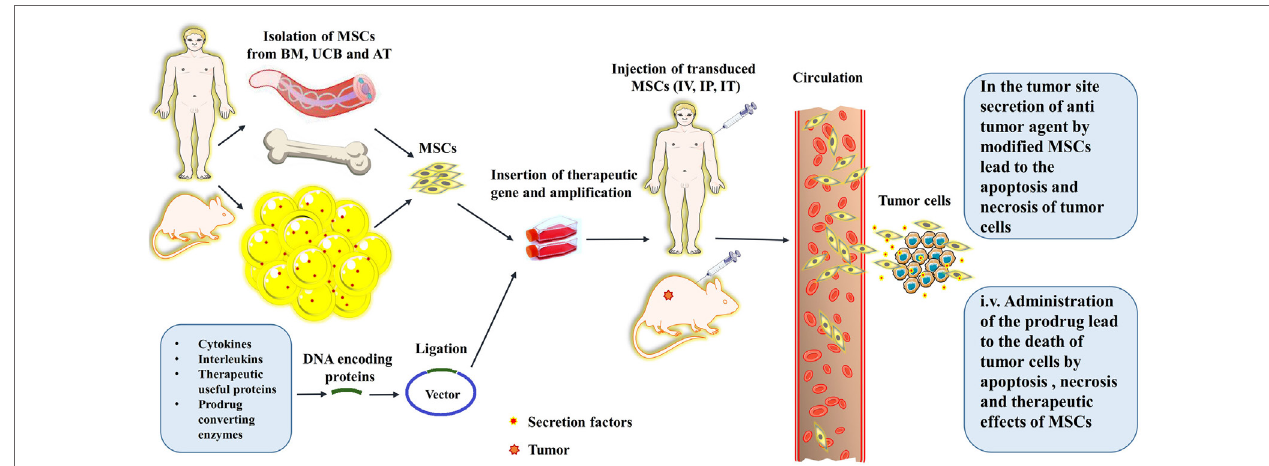
FiGURe 3 | A schematic picture depicts the procedures for the isolation, culture, gene transfer, and in vivo administration of the mesenchymal stromal/stem cells (MSCs). The schema also shows the routes that the MSCs traverse toward their target; tumor sites, and cancerous cells. The abbreviations on the figure include the following: BM, bone marrow; UCB, umbilical cord blood; AT, adipose tissue; IV, intravenous; IT, Intrathecal; IP,